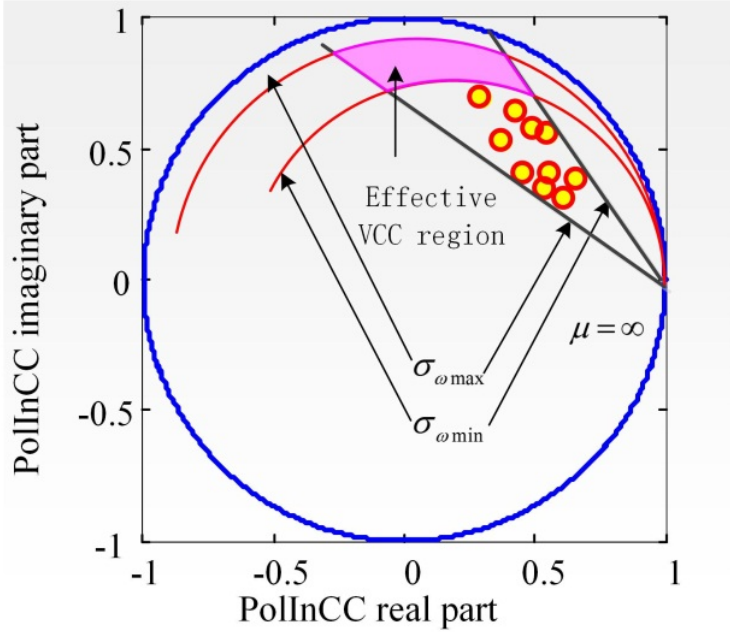
Figure 4. Schematic diagram of the effective VCC distribution region.